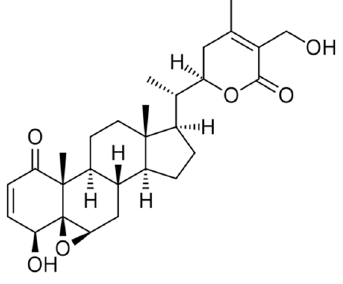
Figure 1. Structure of Withaferin A.